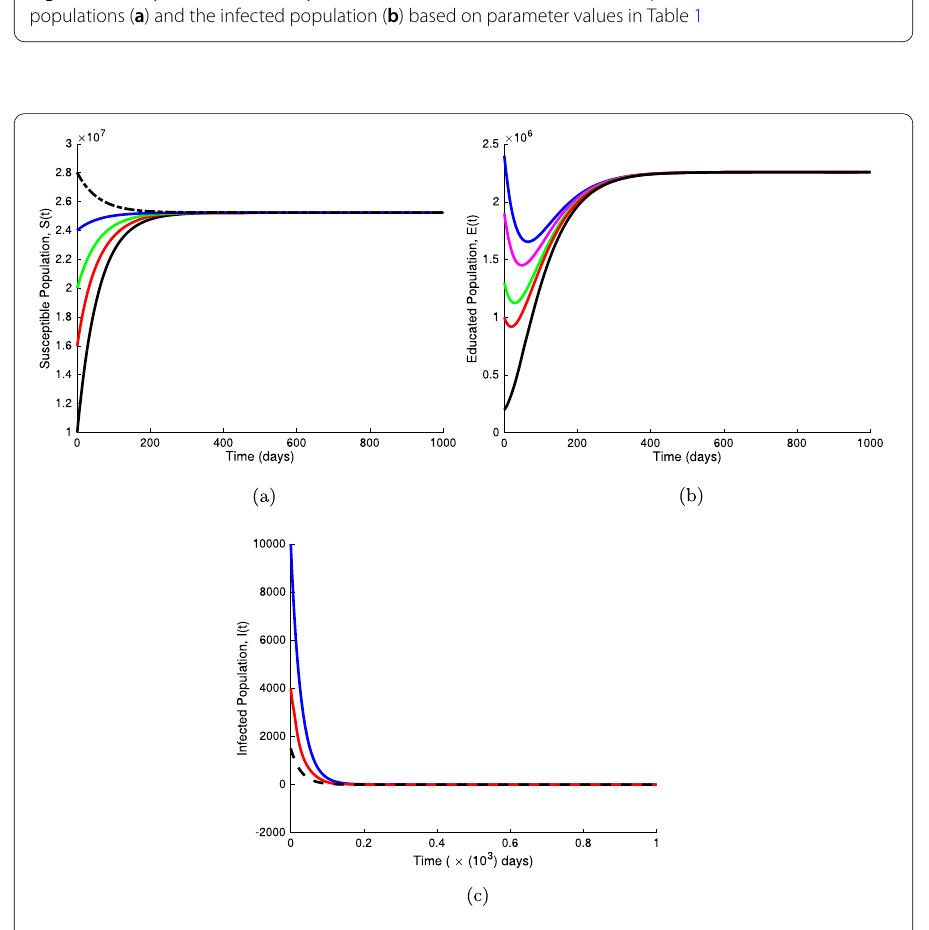
Figure 4 Global stability of the disease-free equilibrium. ( a ): global stability of the disease-free equilibrium when R E = 0.19090 < 1 for the susceptible population. ( b ): global stability of the disease-free equilibrium when R E = 0.19090 < 1 for the educated population. ( c ): global stability of the disease-free equilibrium when R E = 0.19090 < 1 for the infected population. Parameter values are available in Table 1